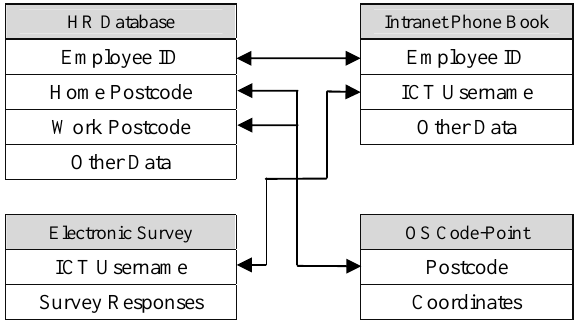
Table 2. Summary of Data Linkages